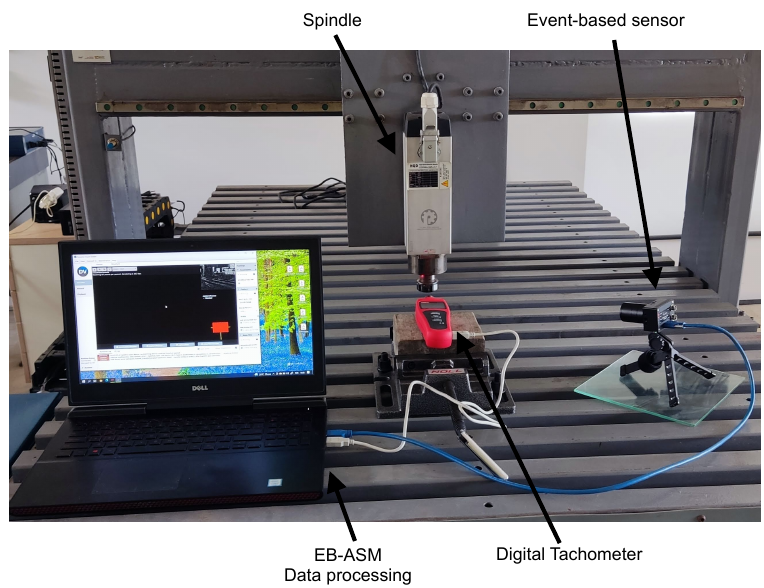
Figure 4. Experimental setup for measuring Router CNC spindle angular speed. The timestamps ( t k ) are recorded in microsecond resolution ( µ s), and the spatial pixel coordinates are recorded accordingly to the pixel position in the spatial resolution. The x k coordinate is a value between 0 and 319 and y k coordinate between 0 and 239. The temporal resolution corresponds to the period to read out all pixels. Thus, the minimum time difference measured for the rotation system is 200 µ s. Figure 3 clearly shows the temporal resolution of this sensor by the sloping clouds of data, where red dots represent positive spikes and purple dots represents negative spikes. Figure 5 represents the top view of Figure 3 and permits see the spikes projected in a single